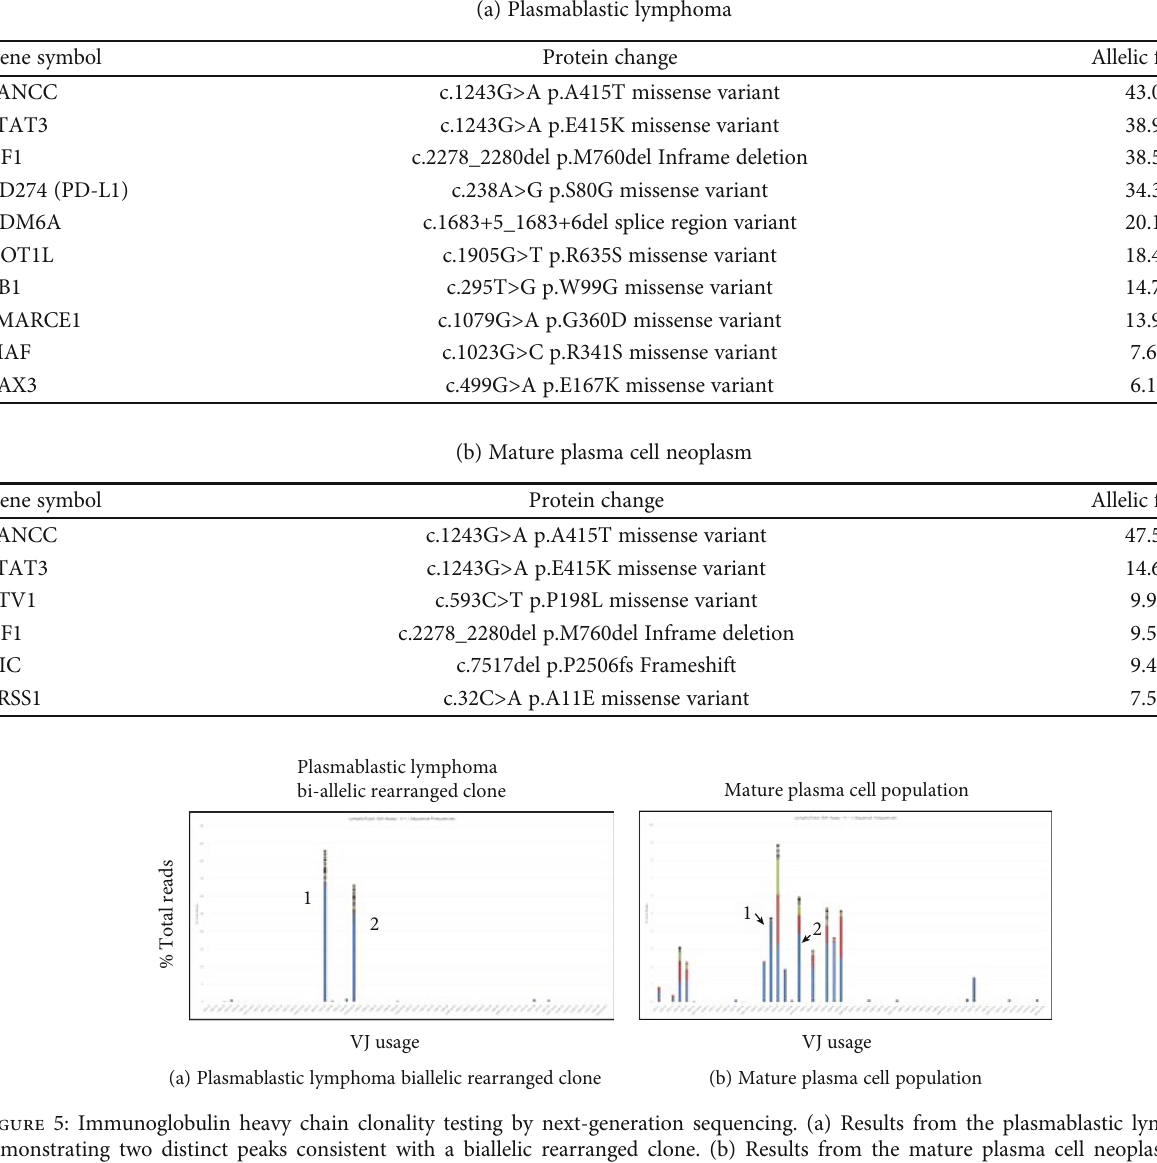
Table 1: Next-generation sequencing targeted panel (596 gene panel). (a) Plasmablastic lymphoma. (b) Mature plasma cell neoplasm.